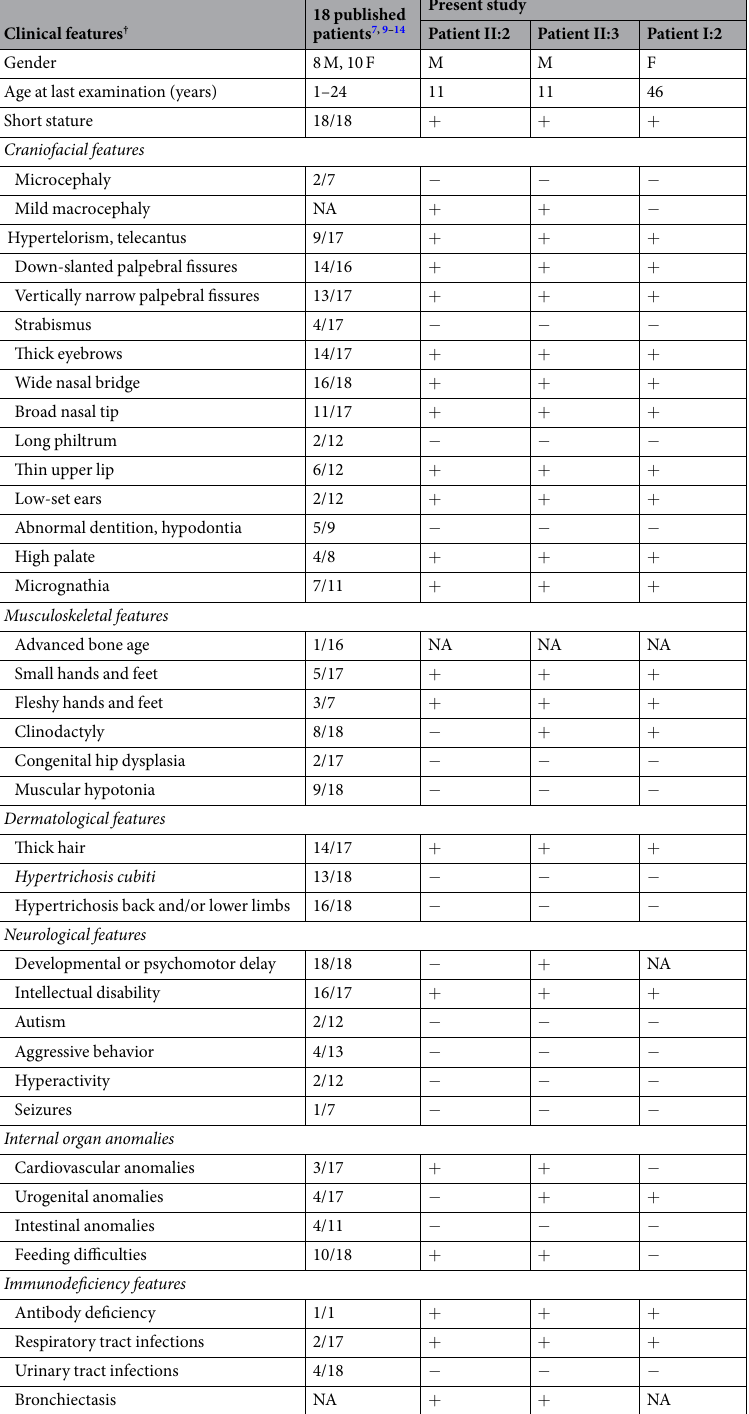
Table 3. Comparison of the family A patients with published cases of KMT2A -associated Wiedemann-Steiner syndrome. NA: not available. † Not all clinical features have been ascertained in all previously published patients. Adapted from Stellacci et al . 7